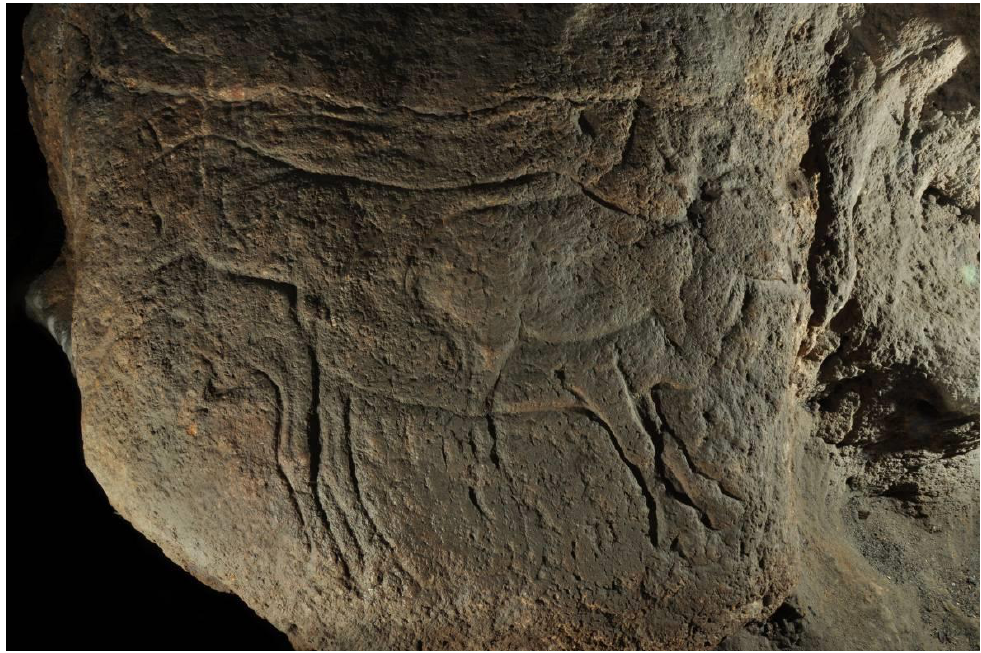
Figure 11. Photograph of the main panel in the Large